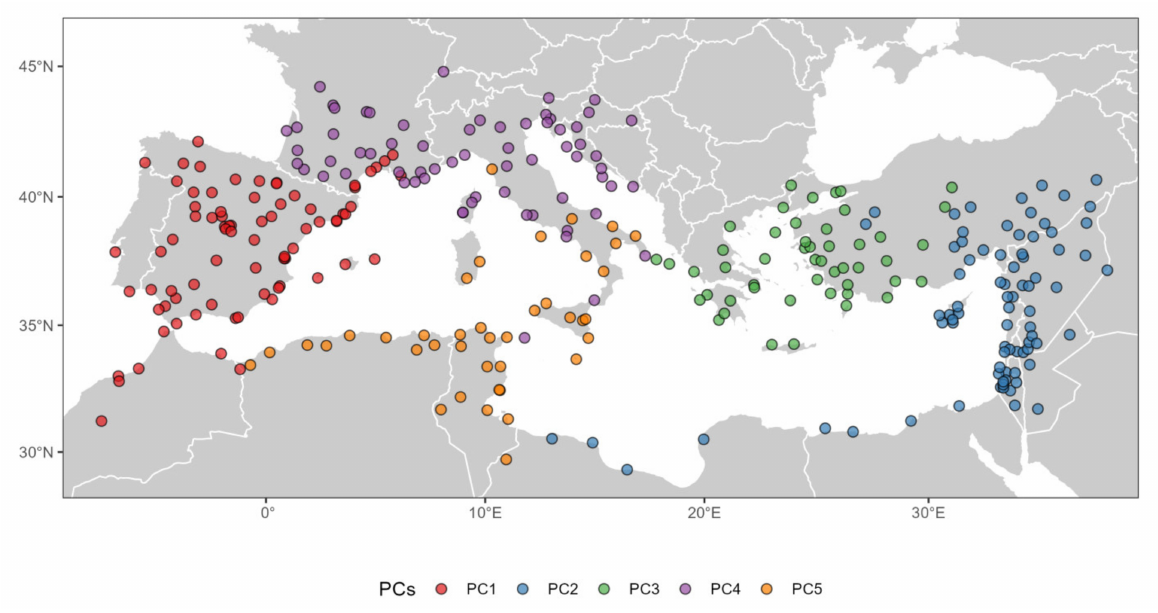
Figure 2. Spatial patterns of the rotated loadings of the five principal components (PCs) based on the principal component analysis (PCA) on the DXI-12.